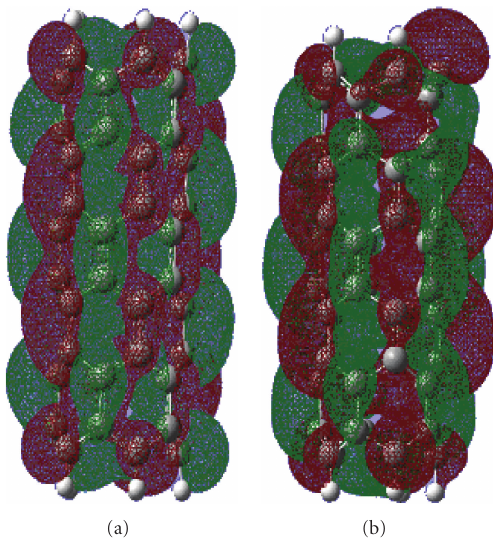
Figure 6: Spatial distribution of the HOMO orbitals for (a) the C 60 H 20 nanotube and (b) the nanotube radical with a missing H atom from the tip C 60 H 19 . The wave function isosurfaces of values +0.01 and − 0.01 (e/ ˚A 3 ) 1 / 2 are shown in red and green, respectively.